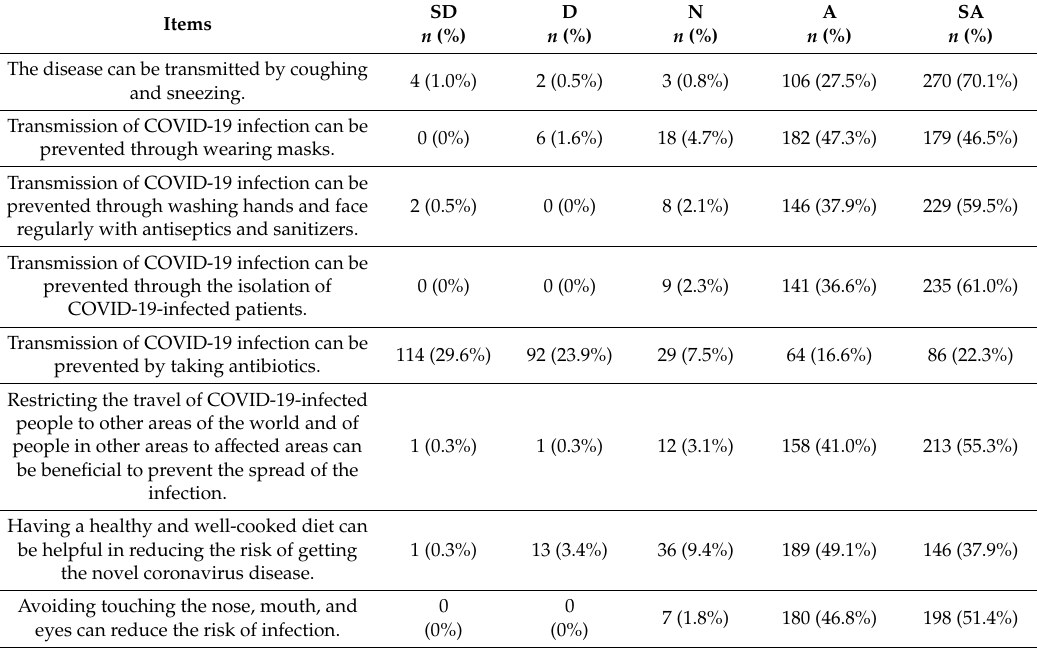
Table 3. Responses to COVID-19-related attitude